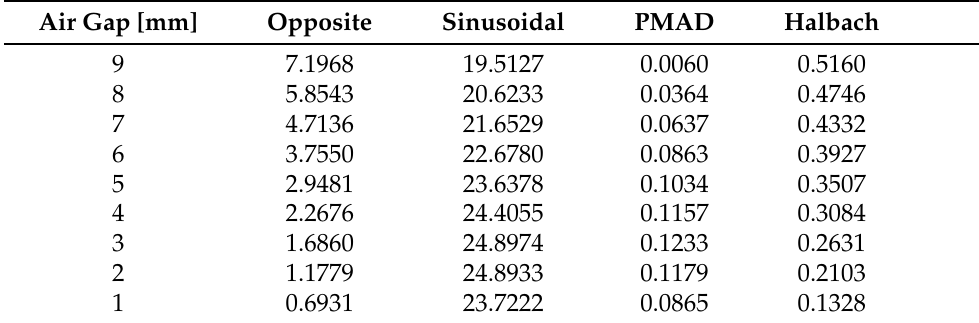
Table 2. Comparison of the percent improvement between the proposed magnetization method and other magnetization methods.